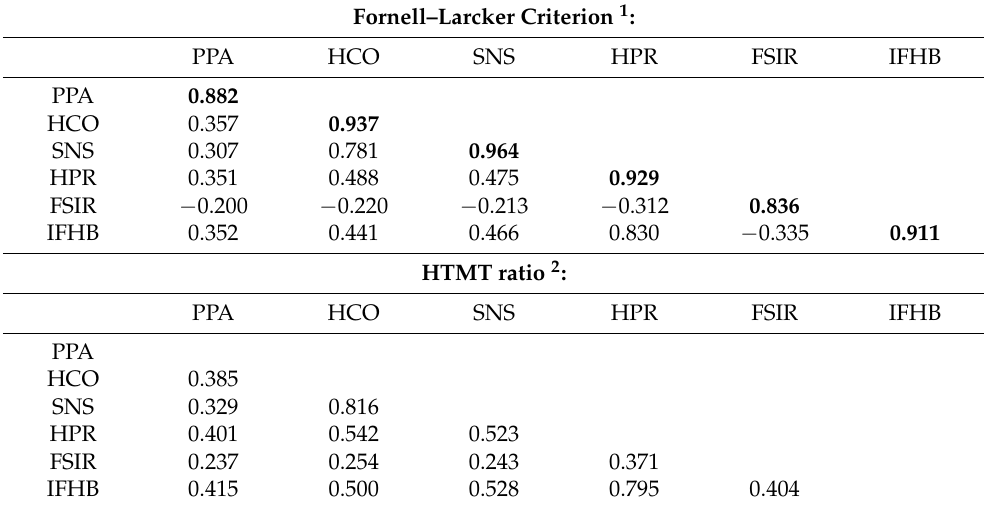
Table 4. Discriminant validity (Fornell–Larcker criterion and HTMT ratio).